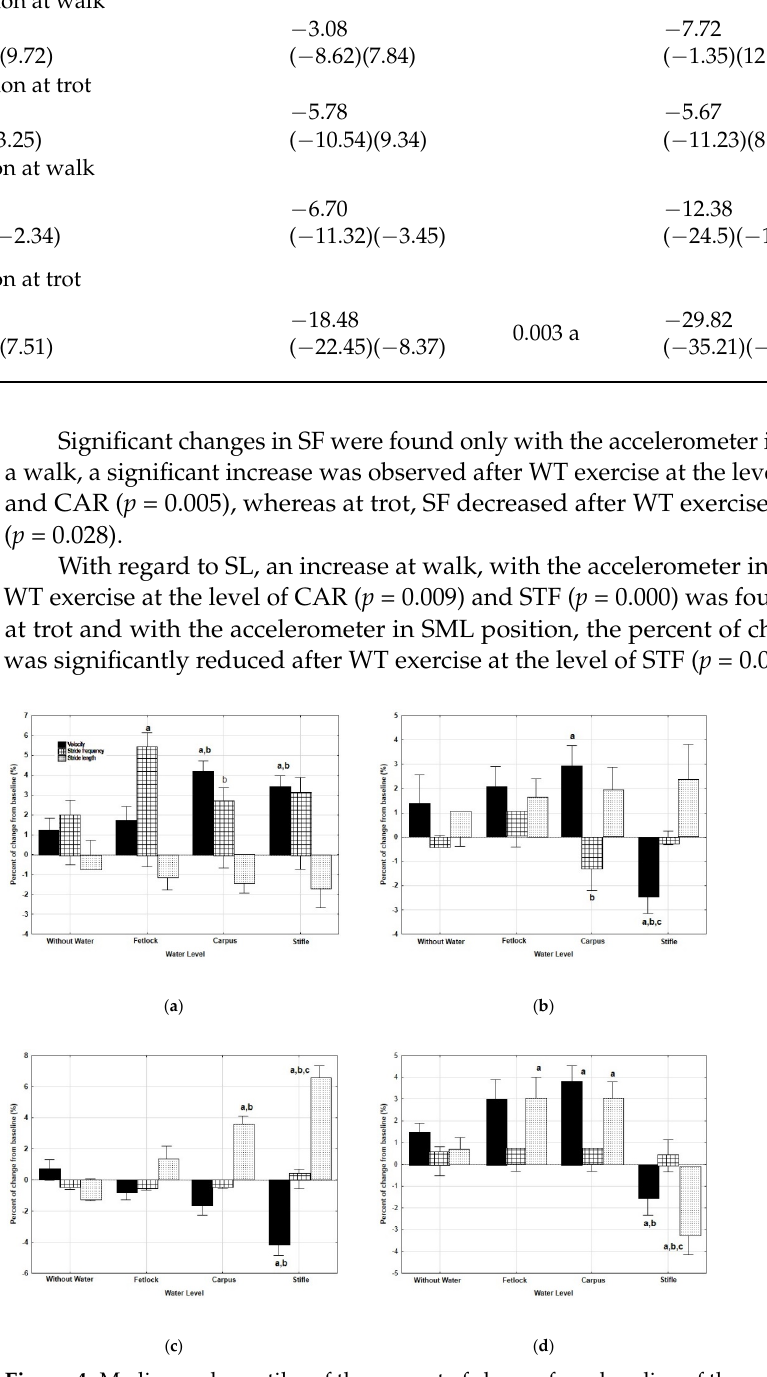
Figure 4. Median and quartiles of the percent of change from baseline of the velocity, stride fre ‐ quency and length, measured on a track after WT exercise sessions at four different water depths, at walk and at trot and with the accelerometer in two different positions (PECT, in the pectoral region; SML, in the sacrum midline). (( a ): at walk with the accelerometer in PECT position; ( b ): at trot with the accelerometer in PECT position; ( c ): at walk with the accelerometer in SML position; ( d ): at trot with the accelerometer in SML position) a: significant differences with treadmill without water; b: significant differences with water at the level of the fetlock; c: significant differences with water at the level of the carpus. p < 0.05. 4. Discussion Exercise on a WT has become popular as a training and rehabilitation tool for sport horses worldwide. This widespread use contrasts with the lack of scientific studies that support its use and lack of standardized protocols according to the objectives pursued. As cited by Tranquille et al. [1], there is little knowledge of optimal WT use and, in some cases, this could raise concerns amongst clinicians and trainers about injury development or exacerbation following its use. In a previous investigation carried out by our research group, we evaluated the ac ‐ celerometric modification in horses during an exercise on a WT at four different water